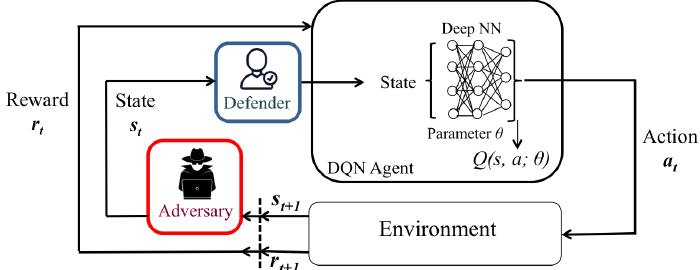
Figure 3. A DQN agent’s structure affected by an adversarial attack and defense